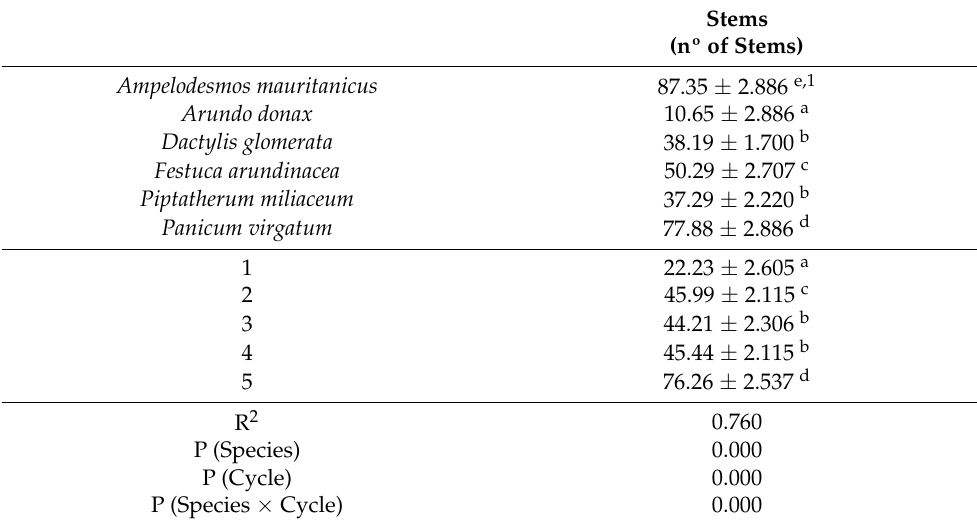
Table 4. Number of stems of the different perennial grasses assayed throughout the whole experiment and for the different growing seasons considering all the species tested